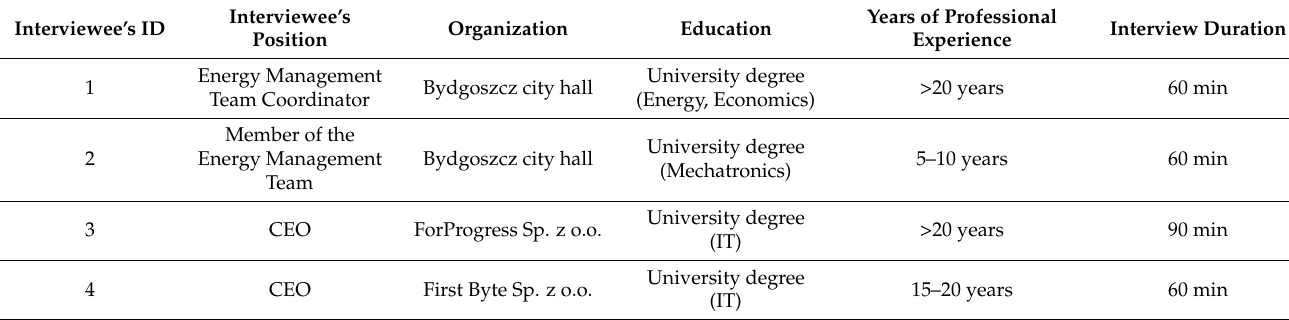
Table 1. List of the